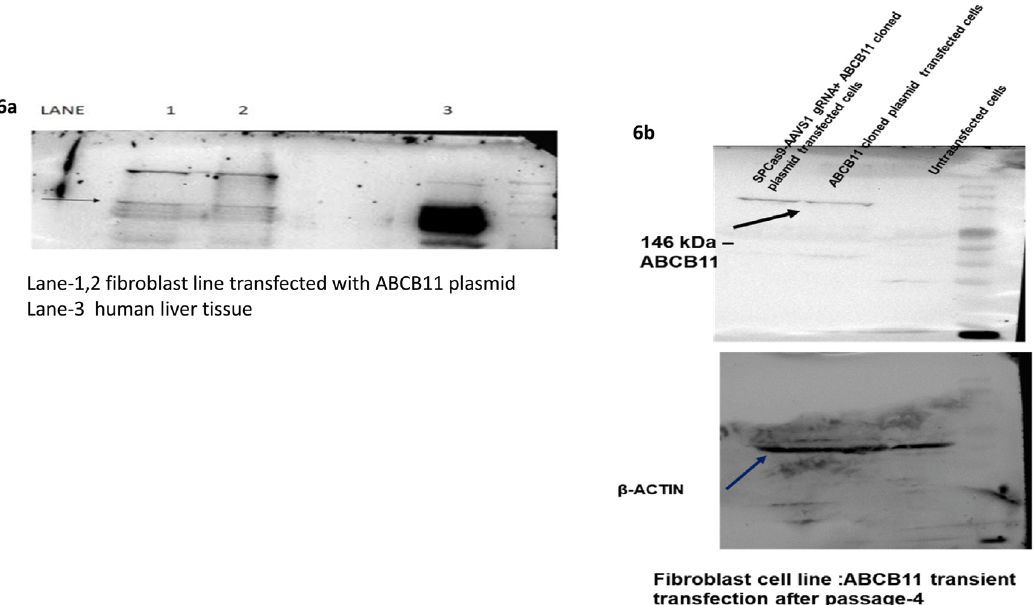
Figure 6. ( a ) Western Blot with anti-human ABCB11 antibody confirmed the expression after transient transfection with the donor vector having ABCB11 . ( b ) Western Blot was done using total protein isolate from fibroblasts (which does not naturally express ABCB11 ) after four passages post-co-transfection of the donor vector with ABCB11 gene and the CRISPR-Cas9-sgRNA vector.